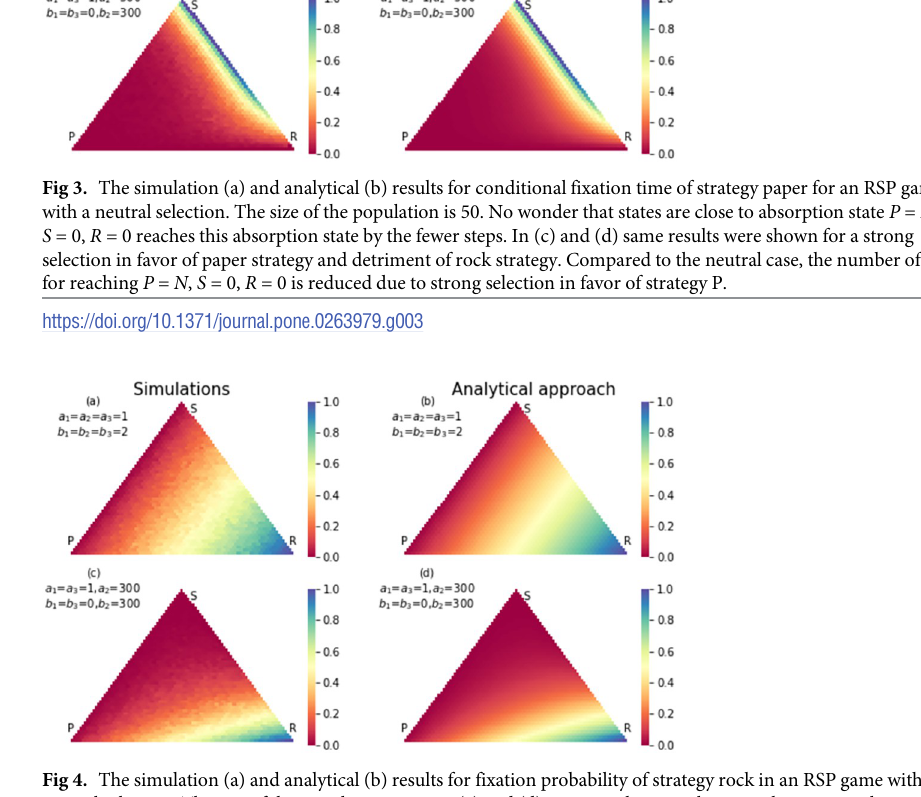
shown in Fig 6, the states which are close to fixation state R = N , S = 0, P = 0, in the strong selection case, absorb in strategy scissors in a shorter time. Also, the conditional fixation time for absorbing in the rock strategy increases in the strong selection case for all simplex states. The reason again is changing the payoff matrix to the detriment of rock strategy. In all figures, the results from the analytical approach and simulations are compared to each other. In most of them, simulation results coincide with analytical results. Still, in Figs 6 and 7 in the part of strong selection, the similarity is not so obvious. Since in some states, the probability of absorption to rock strategy is very low in the strong selection case, we need a lot of realization of the evolutionary game to reach a limited number realization ended in rock strategy. It means simulation should repeat more times for obtaining an accurate result. The same is true for conditional fixation time of scissors strategy. The hardness of getting simulation results in some conditions shows the necessity of invent of an analytical method.